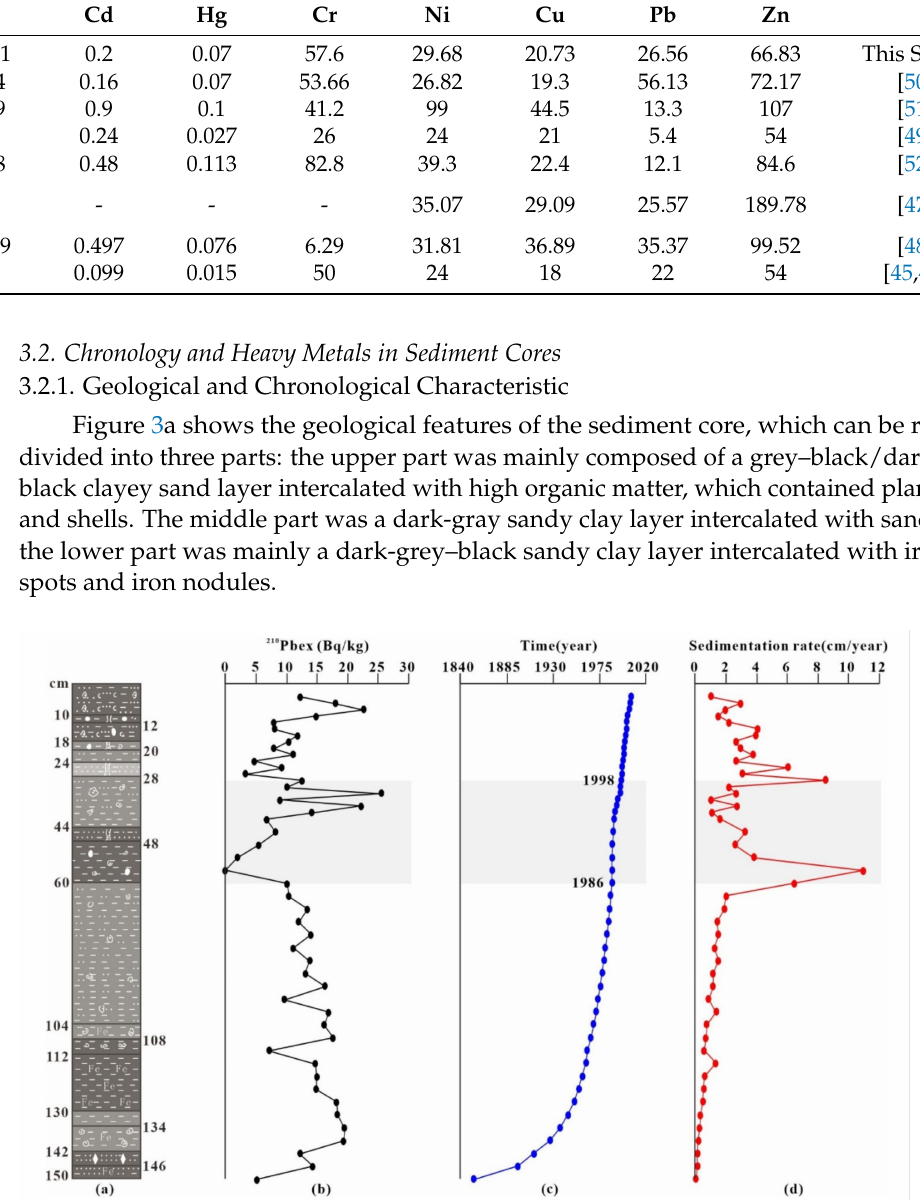
Figure 3. Geological features ( a ), specific activity distribution of 210 Pbex ( b ), chronological sequence dated ( c ), and sedimentation rate by 210 Pb ex Constant Rate of Supply (CRS) ( d ) in the sediment core of the Chagan